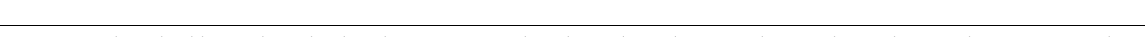
Fig. 3 Tip60 regulates lipid biosynthesis by directly interacting with and acetylating lipin 1. a The TAG biosynthesis pathway in mammalian cells. b Association of Flag-tagged enzymes in TAG synthesis pathway with Myc-tagged Tip60. Protein extracts of HEK293T after transfection were immunoprecipitated with antibody to Flag and immunoblotted as indicated. c Lipin 1 was acetylated by Tip60 in vitro. Bacterially expressed His-lipin 1 was incubated with His-Tip60 in the presence or absence of acetyl-CoA (Ac-CoA) and immunoblotted as indicated. d Tip60-dependent acetylation of lipin 1. 3T3-L1 adipocytes expressing control shRNA (ctrl) or shRNAs targeting Tip60 were treated with or without OA for 3 h. Acetylated proteins were immunoprecipitated with antibody to acetylated lysine, followed by immunoblotting. e Tip60 inhibitor MG149 abrogates the acetylation of lipin1 mediated by Tip60. Flag-tagged lipin 1 co-transfected with or without Tip60 in HEK293T cells treated or untreated with MG149 for 3 h were immunoprecipitated by antibody to Flag and immunoblotted as indicated. f Reduced acetyltransferase activity of Tip60-S86A towards lipin 1. Flag-tagged Tip60 or its S86A mutant expressed in HEK293 cells was immunoprecipitated with antibody to Flag. In vitro acetylation assays were performed using puri fi ed His-lipin 1 as substrate ( n = 4 experiments). g Tip60-dependent acetylation of lipin 1 in vivo. eWAT from WT or Tip60 SA/SA ND or HFD mice was immunoprecipitated by using antibody to acetylated lysine or Tip60, followed by immunoblotting. Each lane represents a different individual ( n = 3 experiments). h Biosynthesis of phospholipids and neutral lipids from glycerol-3-phosphate (G3P) in mammalian cells. i Total levels of PA (left) and individual PA species (right) normalized to cellular protein in eWAT from 6-week-old WT and Tip60 SA/SA mice. The molecular species of PA are indicated as total number of carbons/ number of double bonds ( n = 3 individuals for each group). j Total levels of DAG normalized to cellular protein in eWAT from 6-week-old WT and Tip60 SA/ SA mice ( n = 3 individuals for each group). k , l Identi fi cation of acetylation sites on lipin 1 targeted by Tip60. WT-lipin 1 or its lysine-to-arginine (KR) mutants were co-expressed with or without Tip60 in HEK293T cells, immunoprecipitated by antibody to Flag and immunoblotted as indicated ( k ). His- tagged WT-lipin 1 or its KR mutants were incubated with Tip60 in the presence or absence of Ac-CoA and immunoblotted as indicated ( l ). m Sequence alignment of the residues fl anking Lys 425 across different species. Arrowheads point to the Lys 425 residue corresponding to human lipin 1. Error bars denote SEM. Statistical analysis was performed by ANOVA followed by Tukey in g or by two-tailed unpaired Student ’ s t -test in f , i and j . * P < 0.05; ** P < 0.01. Uncropped blots can be found in Supplementary Fig.